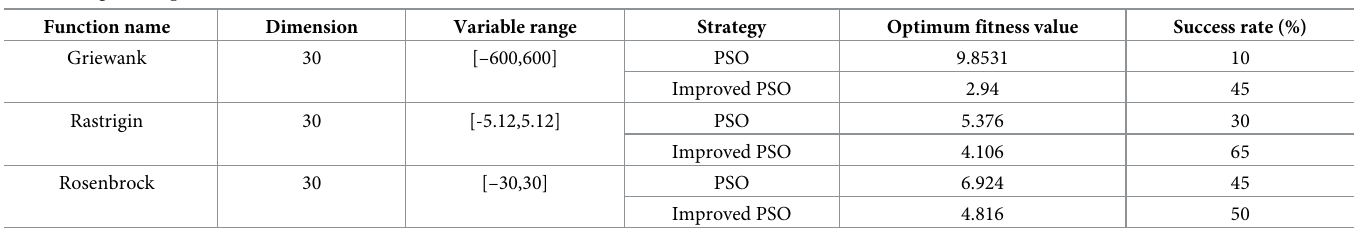
Table 1. Algorithm performance test